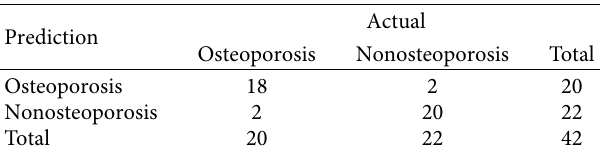
Table 4: Testing’s